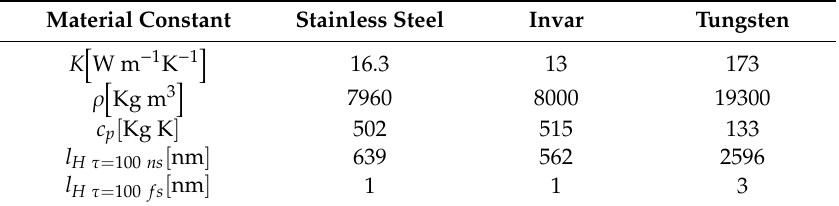
Table 1. Material constants provided by the supplier (Goodfellow GmbH) and heat di ff usion lengths calculated for 100 ns and 100 fs pulse durations.